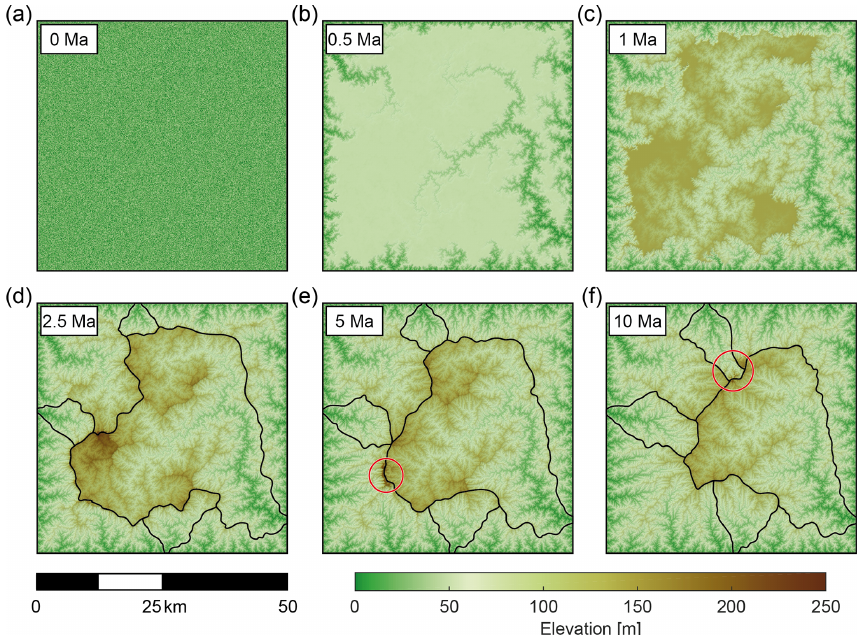
Figure 3. Map view of the temporal evolution of the reference model. Colour bar gives the model elevation. Black lines show the evolution – and the migration – over time of drainage divides for five drainage basins. Red circles in (e) and (f) show transient topography associated with drainage capture after 5 and 10Myr of simulation, respectively (see video no. 1 in the